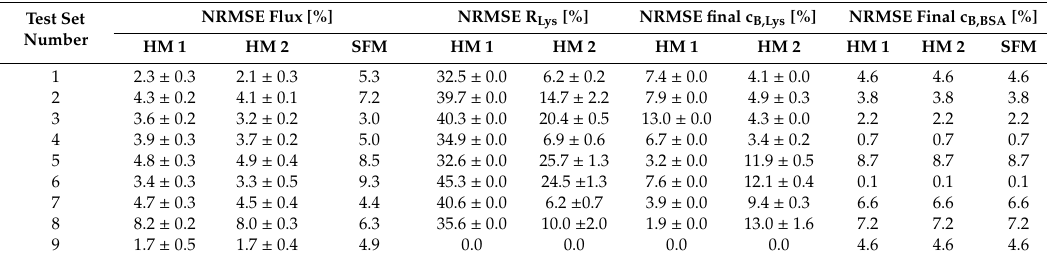
Table A3 contains the prediction errors of HM 1 and 2 regarding flux, R Lys , and final c B,BSA, and c B,Lys prediction. The c B,BSA predictions are identical for both hybrid models because R BSA is 1. Test run 9 contained no lysozyme, therefore no R Lys and c B,Lys error was calculated. The HM 2 NRMSE for final c B,Lys show clear di ff erences between test run 1 − 4 (input parameters inside the trained space) and test run 5 − 8 (at least one input parameter outside the trained space). Table A3. Summary of the test sets with varying initial c B s, CF, and TMP, and the number of samples taken to calculate the observed R.